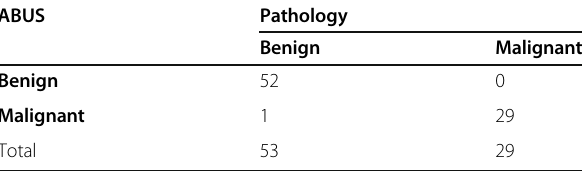
Table 4 Correlation between ABUS results and pathology ABUS